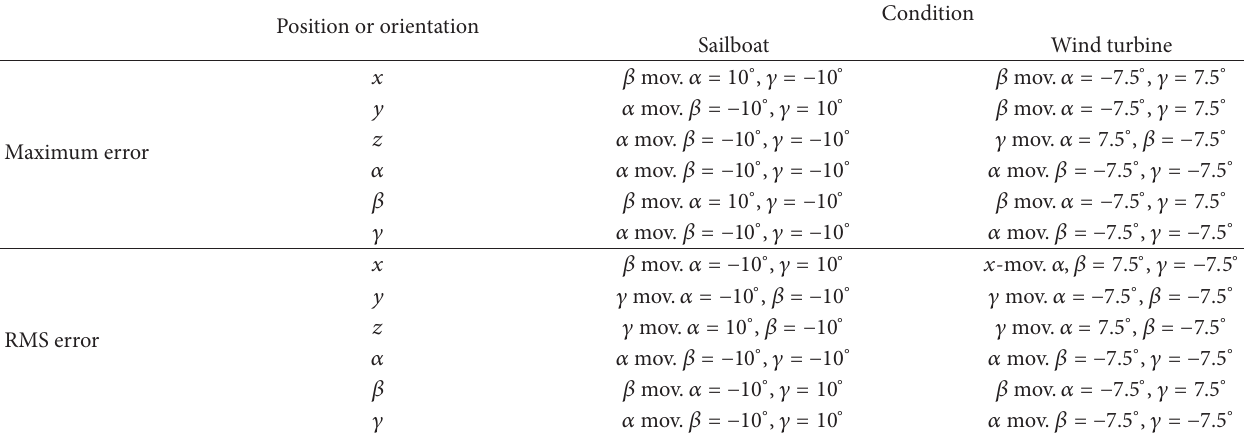
Table 4: Conditions of maximum error and maximum RMS of the